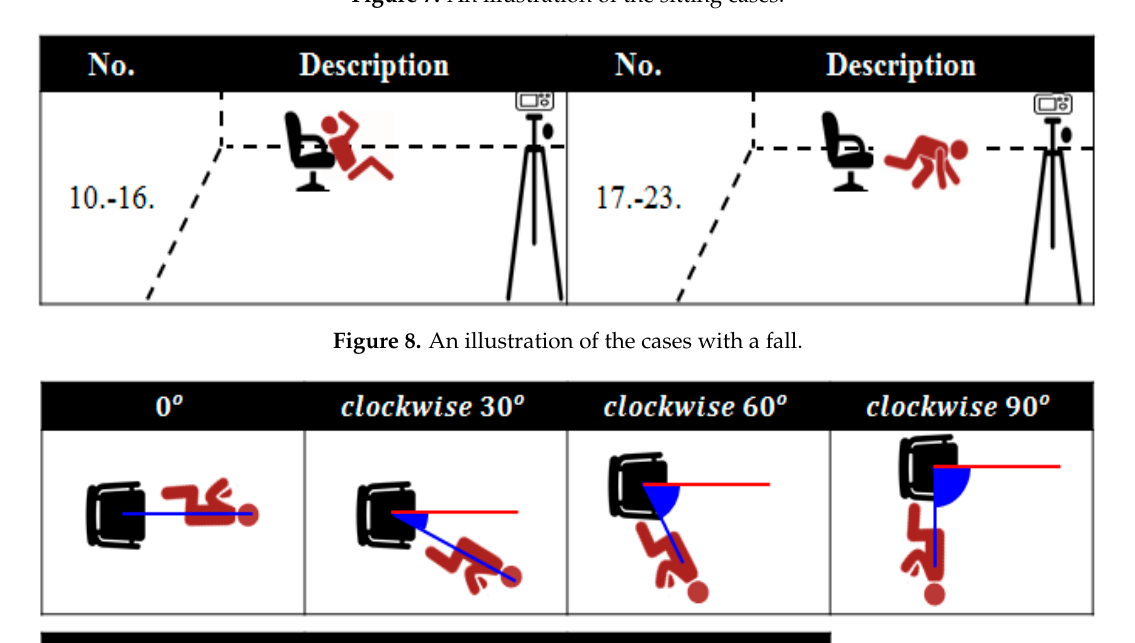
Figure 7. An illustration of the sitting cases.